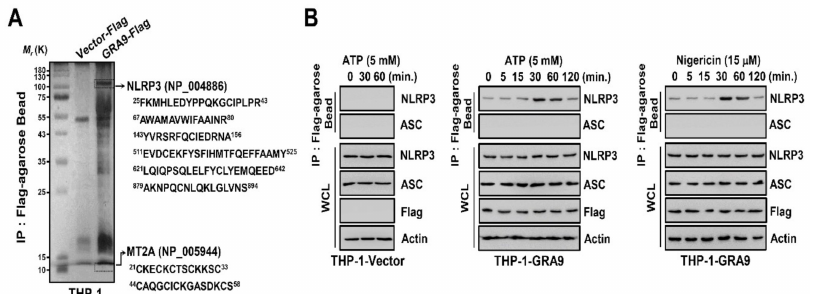
Figure 1. GRA9 binds with NLRP3. ( A ) Identification of NLRP3 by mass spectrometry analysis in THP-1 cell lysates expressed with GRA9 or vector. ( B ) Vector or GRA9 expressing THP-1 cells were primed with LPS (100 ng · mL − 1 ) and stimulated with ATP or Nigericin (5 mM or 15 µ M) for the indicated times, followed by immunoprecipitation (IP) with α Flag-agarose bead and immunoblotting (IB) with α NLRP3, α ASC, α Flag, and α Actin. The data are representative of four independent experiments with similar results ( A , B ). Full-length images of the blots presented in the Figure